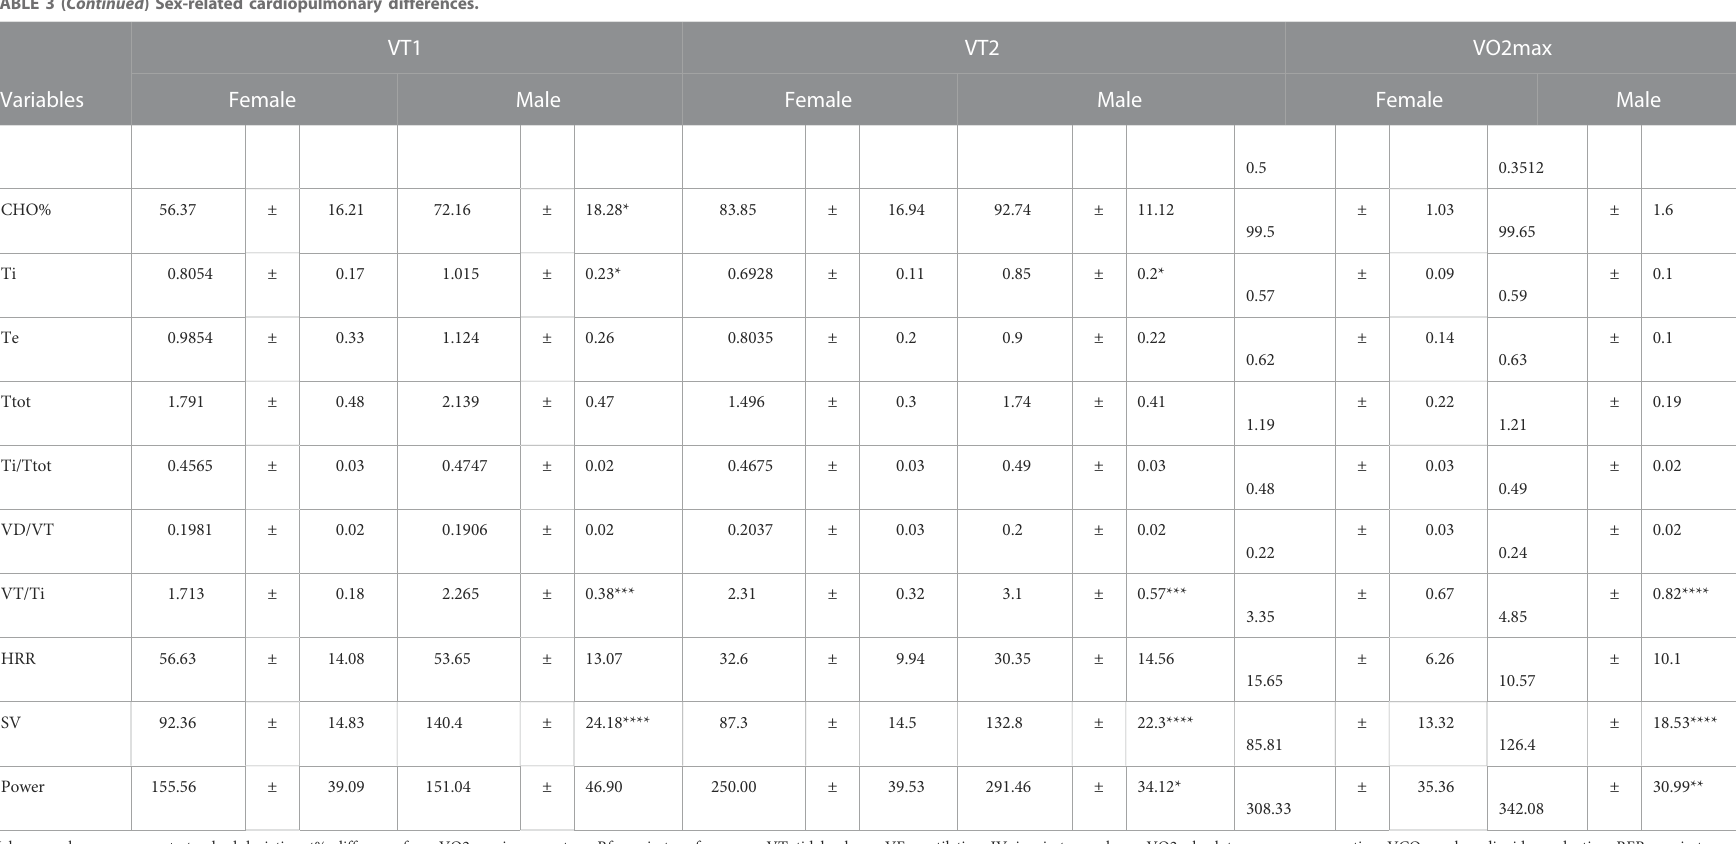
Values are shown as mean ± standard deviation. t%: difference from VO2max in percentage; Rf: respiratory frequency; VT: tidal volume; VE: ventilation; IV: inspiratory volume; VO2: absolute oxygen consumption; VCO 2 : carbon dioxide production; RER: respiratory exchange ratio; VE/O2: ventilatory equivalent for oxygen; VE/CO 2 : ventilatory equivalent for carbon dioxide; VO2/kg: relative oxygen consumption; METs: metabolic equivalent of task; HR: heart rate; VO2/HR: oxygen pulse; PetO2: end tidal partial pressure of oxygen; PetCO2: end tidal partial pressure of carbon dioxide; FAT%: percentage of energy from fat; CHO%: percentage of energy from carbohydrate; Ti: inspiratory time; Te: expiratory time; Ttot: respiratory cycle duration; Ti/Ttot: inspiratory time divided by respiratory cycle duration; VD/VT: dead space; VT/Ti: ventilatory drive; HRR: heart rate reserve; SV: stroke volume. * p < 0.05; ** p < 0.01; *** p < 0.001 and **** p <